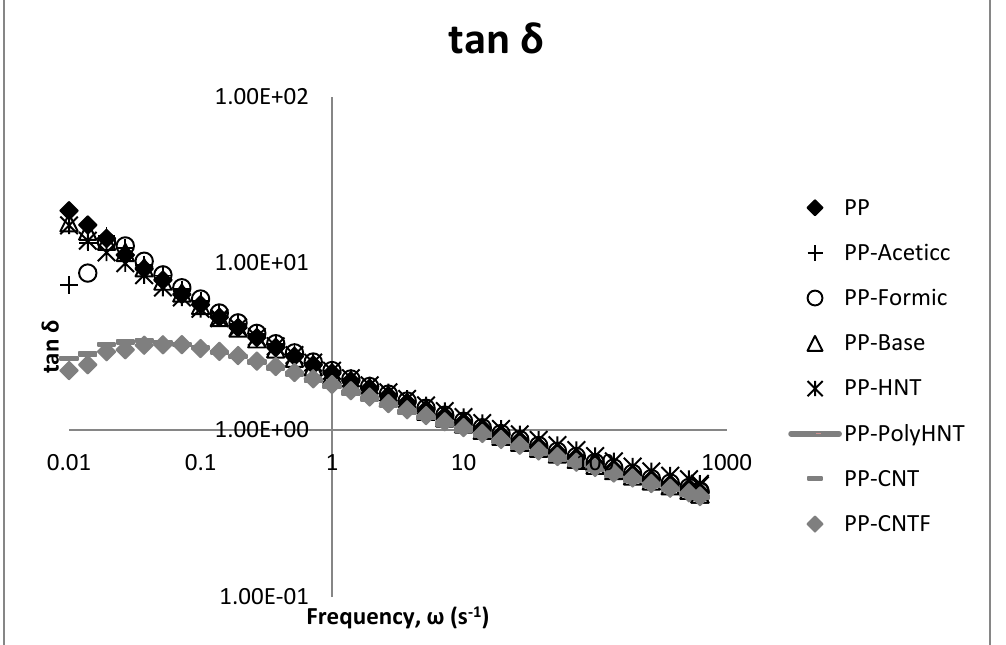
Figure 8. tan δ with frequency sweeps as a function of the filler